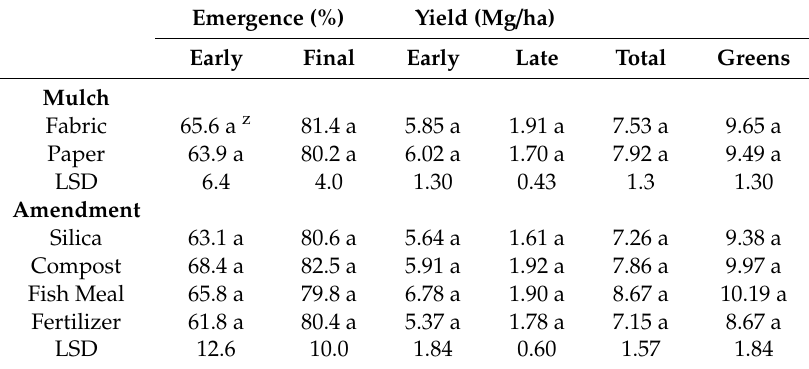
Figure 2. Average total yield of ( A ) green snap beans and ( B ) zucchini squash over two consecutive growing seasons (combined data for 2017 and 2018) and as a ff ected by di ff erent soil amendments. Bars topped by the same letter for each vegetable are not significantly di ff erent based on Fisher’s protected LSD test ( p < 0.05). Compost = Composted dairy manure; Silica = Compost plus silicon (Si) as Wollastonite; Fish meal = Compost plus organic fish meal (high N fertilizer); Fertilizer = commercial organic fertilizer-only treatment (no compost). Table 7. Average early and final emergence and total, early, and late harvest vegetable yield, as well as total yield of turnip greens for turnip crop combined over the 2017 and 2018 growing seasons, and as a ff ected by mulch type and soil